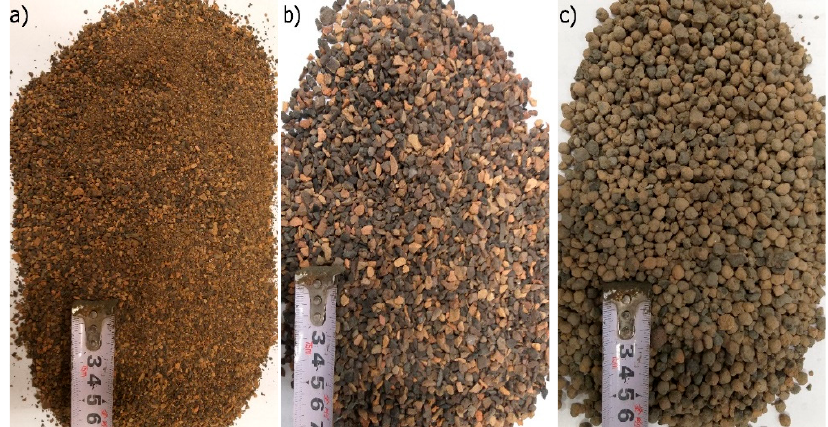
Figure 3. Artificial lightweight aggregate fractions: ( a ) 0–2; ( b ) 1–4; ( c ) 4–8 mm.